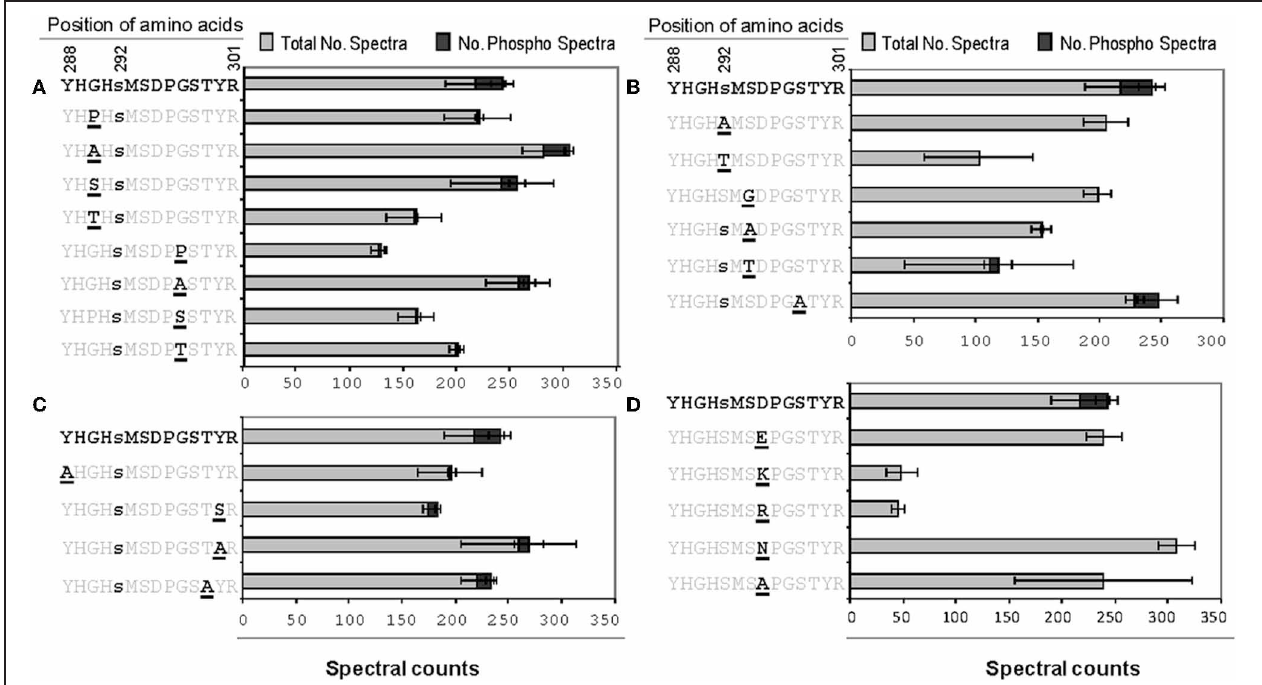
FIGURE A3 | The effects of single changes to the amino acid residues flanking phosphorylation site 1 of A. thaliana PDH E1 α . The spectral count data presented are means of three technical replicates each for both phosphorylated and non-phosphorylated peptides.